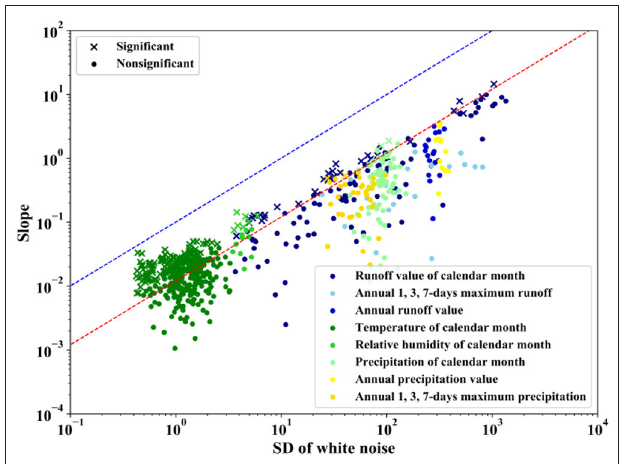
FIGURE 7 | Slope values against the SD of white noise.